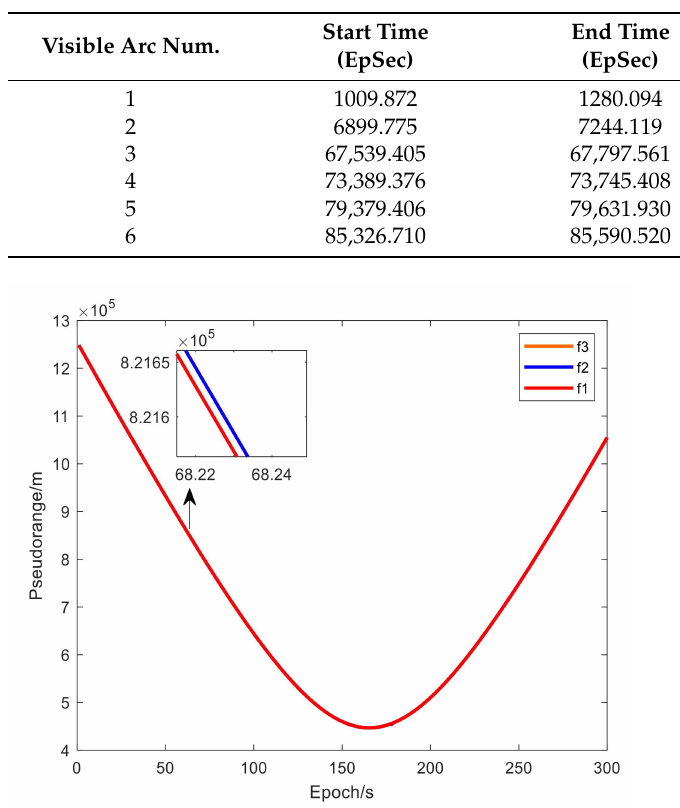
Table 3. Visibility results in one day.